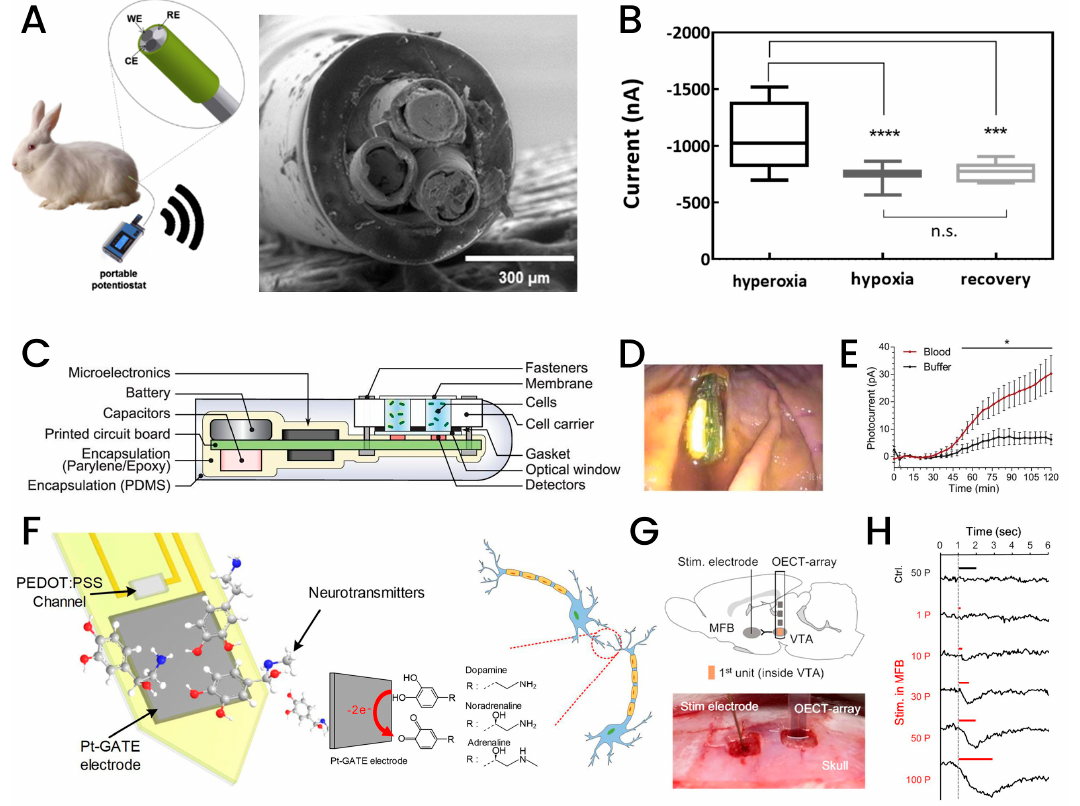
Figure 9. Typical applications of biochemical sensing via implantable biosensors. ( A ) Oxygen